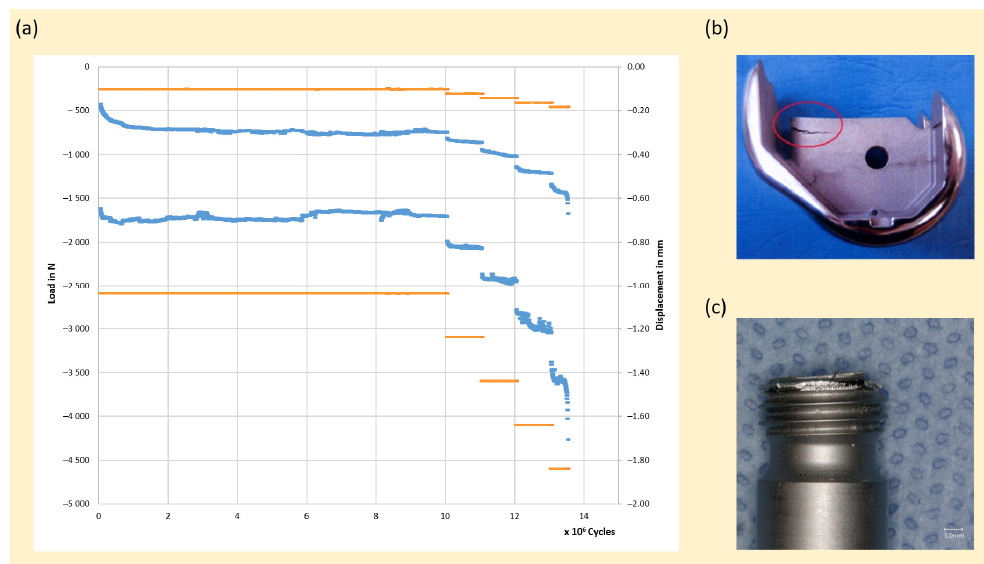
Figure 5. Experimental results of custom-made implant 1. ( a ) Load and displacement curves relative to cycles. ( b ) Mechanical fracture of one sample of reference implant 1. ( c ) Fracture of the stem connected to custom-made implant 1.